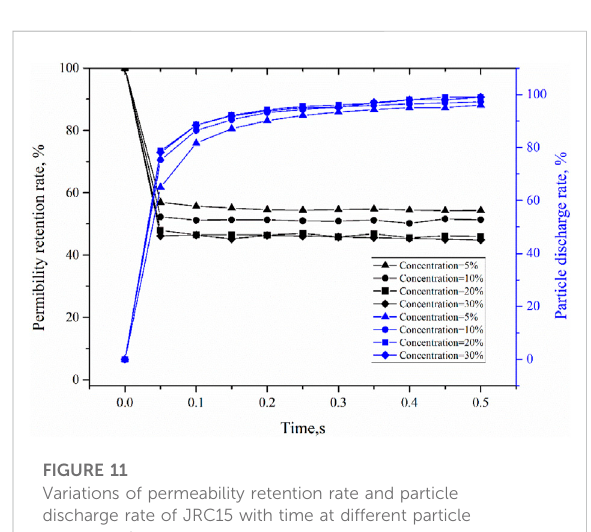
FIGURE 11 Variations of permeability retention rate and particle discharge rate of JRC15 with time at different particle